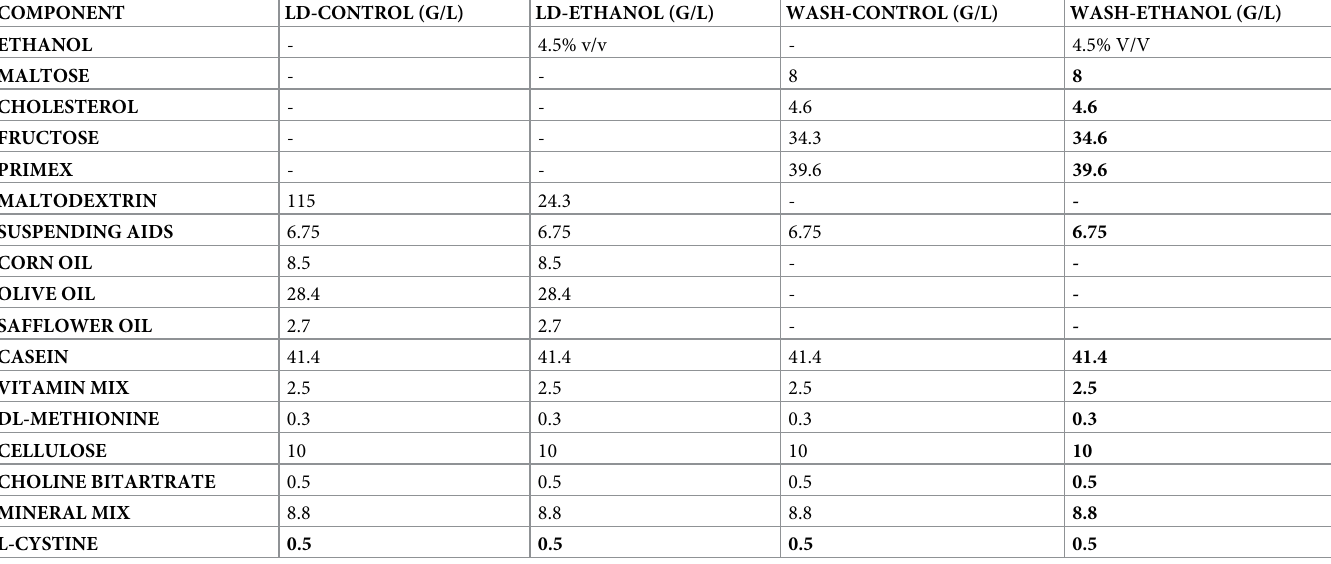
Table 1. Composition of the high fat, fructose and cholesterol “western” alcohol-induced steatohepatitis diet (WASH) compared to the standard Lieber-DeCarli diet.